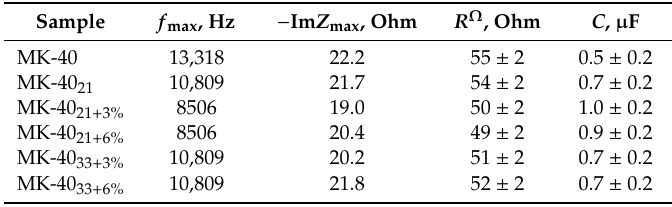
Table 2. Characteristic points of the high-frequency region of the studied membranes impedance spectra and the e ff ective capacities of the electric double layer and the ohmic resistances of the membranes found from these